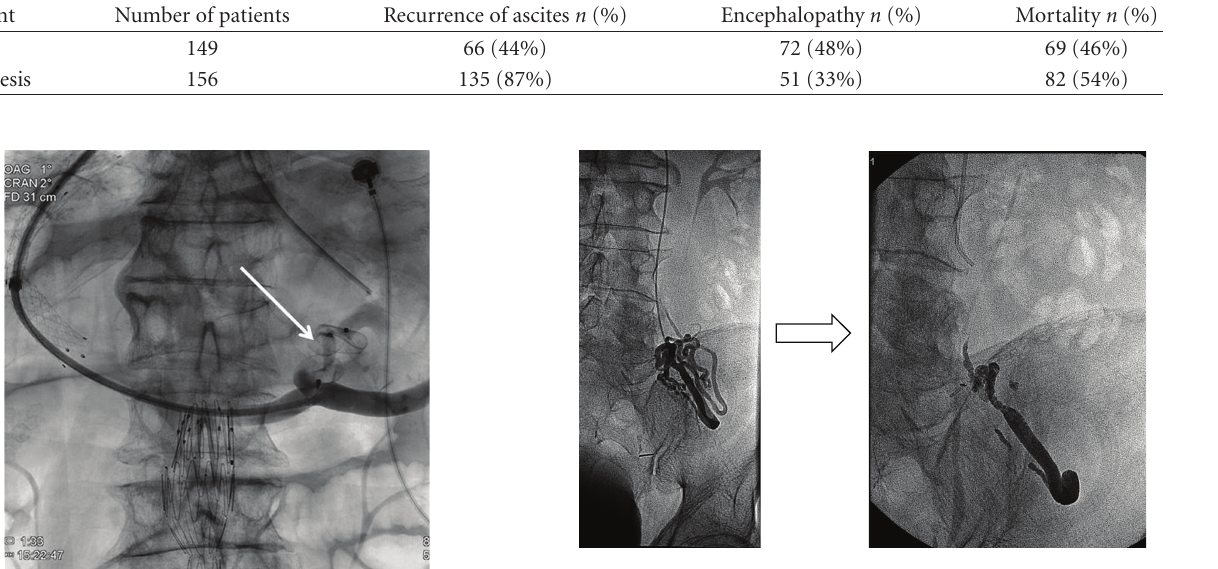
Figure 7: (a) Stomal varices in a patient with cirrhosis and colostomy. (b) Treatment of stomal varices with TIPS and emboliza- tion using histoacryl